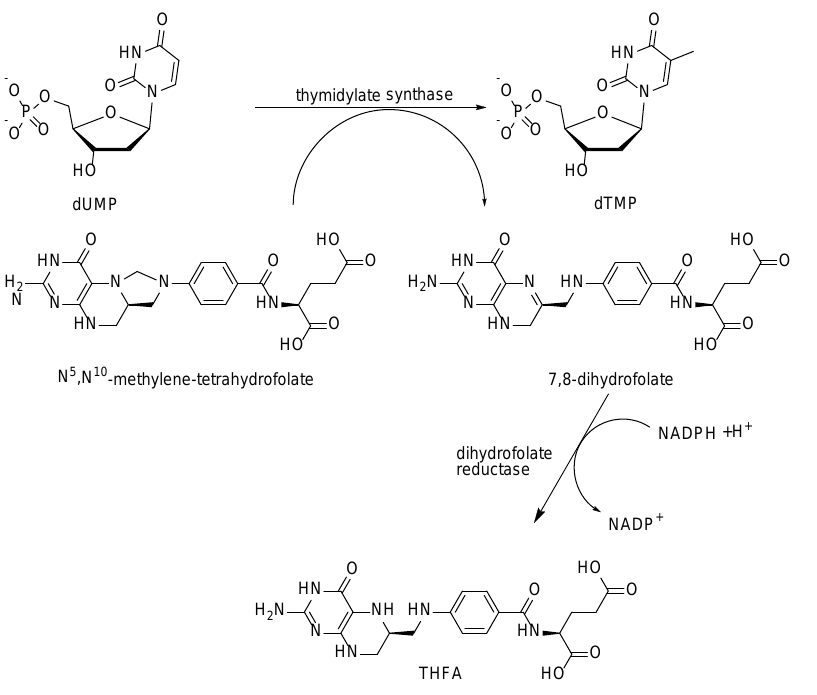
Figure 1. Structure of folic acid ( 1 ) and tetrahydrofolic acid (THFA) ( 2 ) and their antimetabolites. Scheme 1. Main target processes for antifolates in living cells.